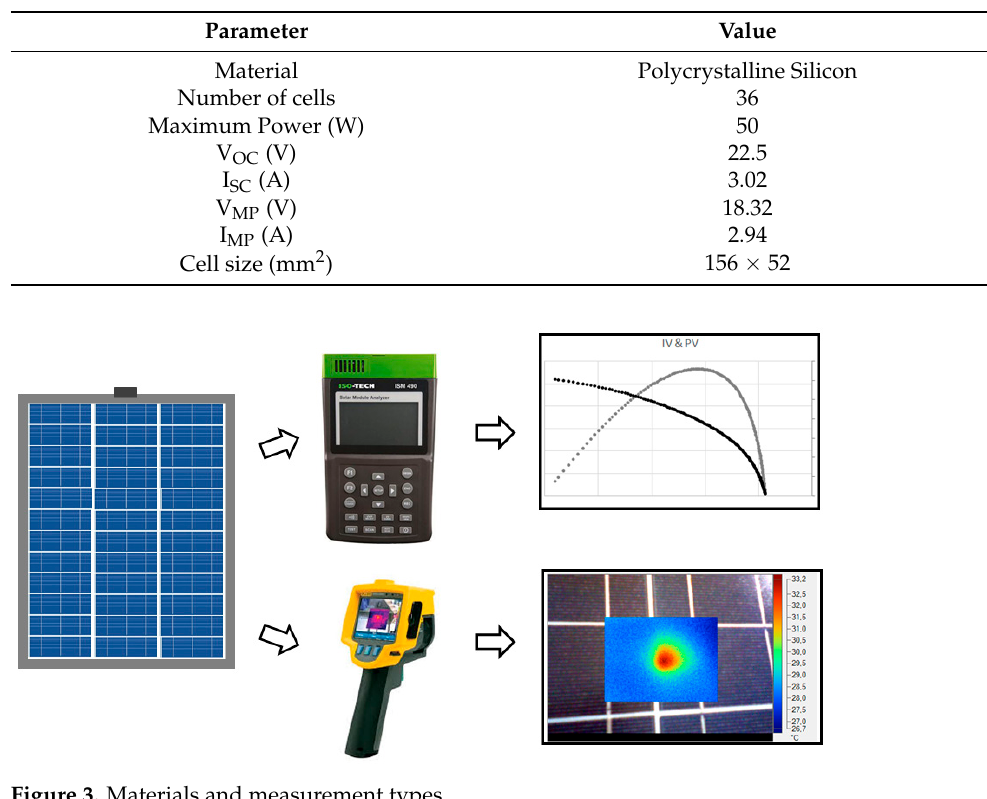
Figure 3. Materials and measurement types. Table 1. Characteristics of the PV panel.